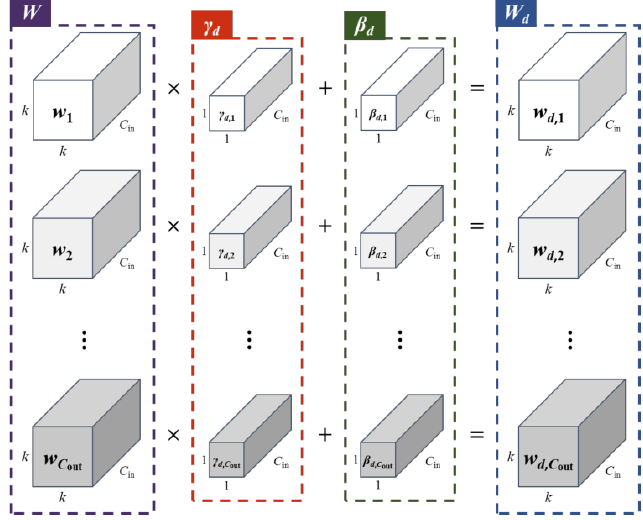
Figure 4. R ate-adaptive scaling and shifting